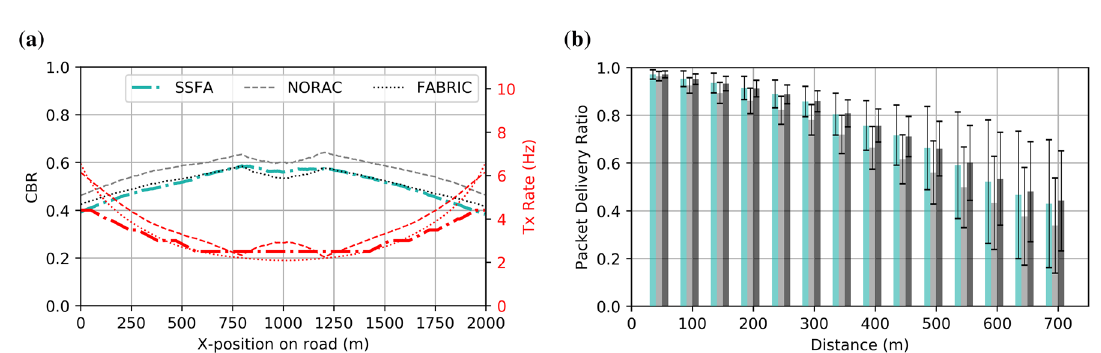
Figure 4. Realistic simulation (OMNeT ++) of our proposed congestion control approach compared to FABRIC and NORAC for an evenly spaced row of vehicles. ( a ) Beaconing rate and CBR measured versus the vehicles’ position on the road; ( b ) Packet Delivery Ratio over different